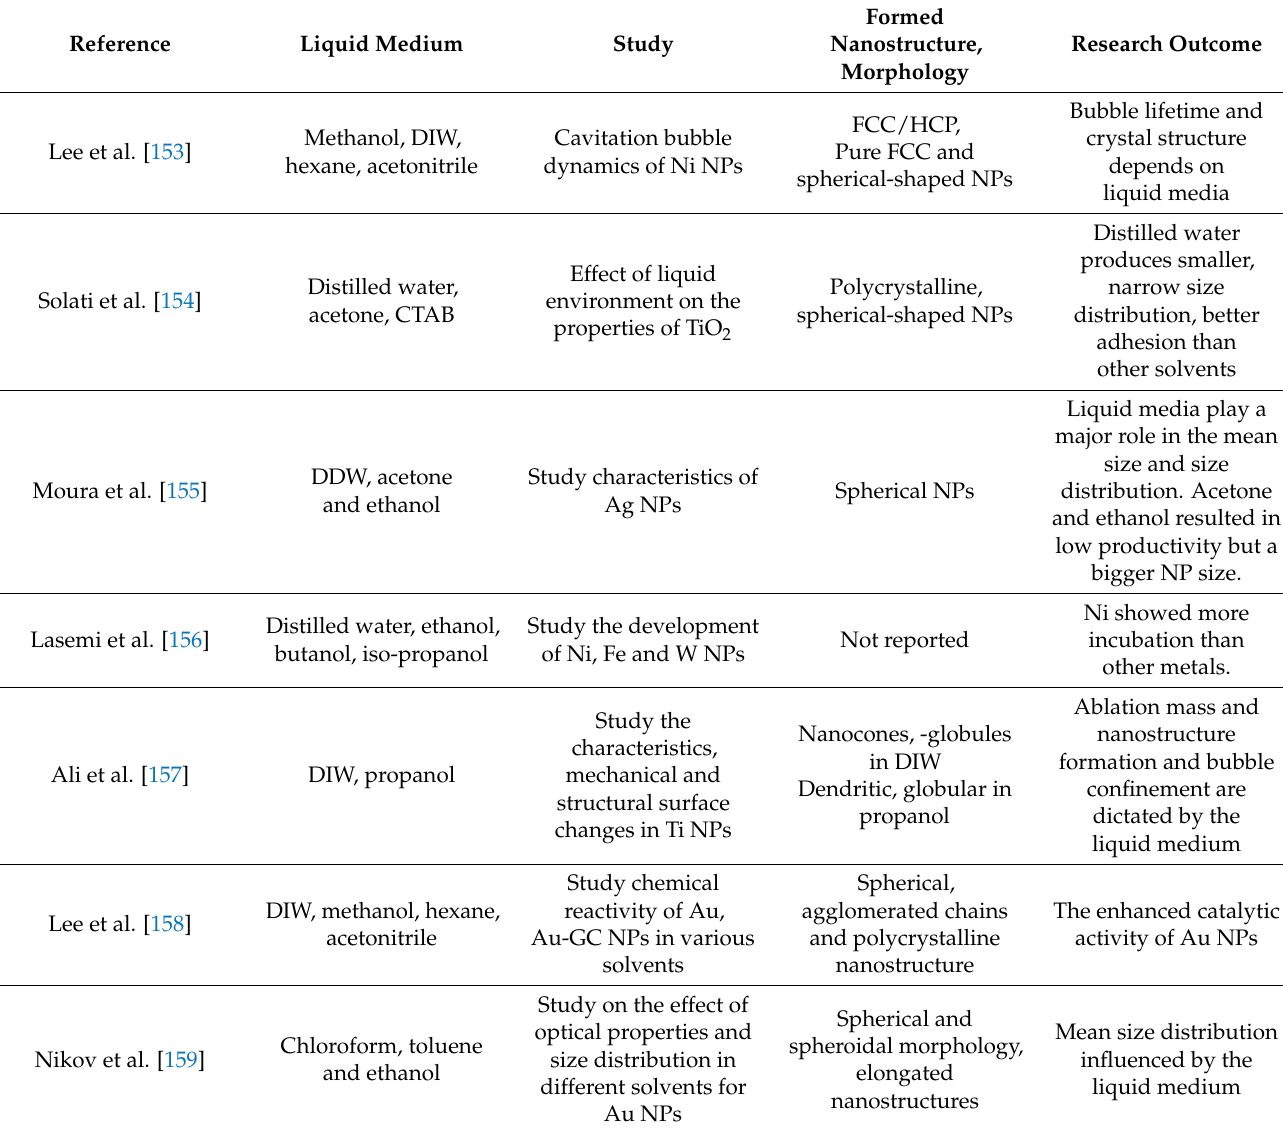
Table 3. State of the art studies conducted to examine the influence of liquid media on nanoparticle